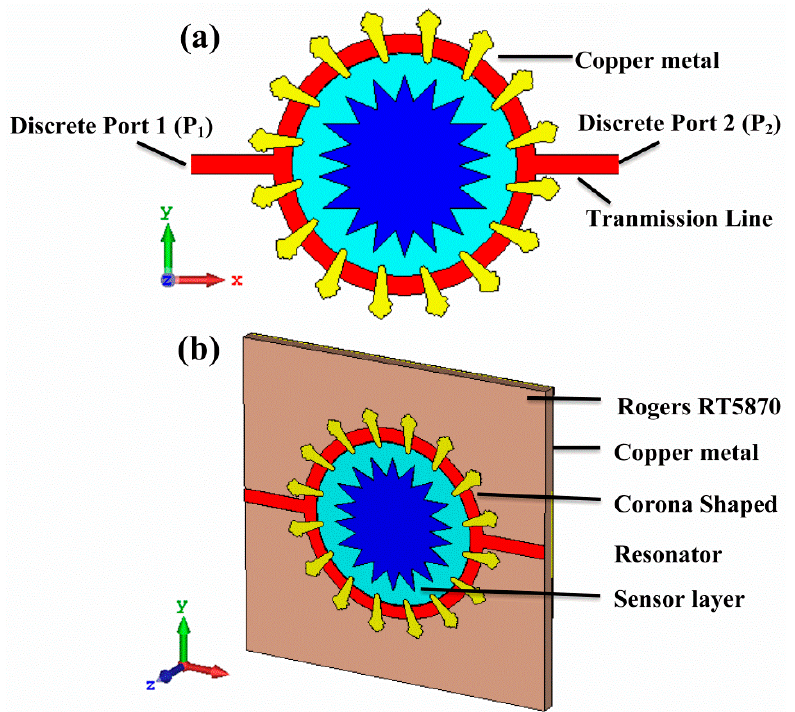
Table 1. Dimensions of the proposed structure.